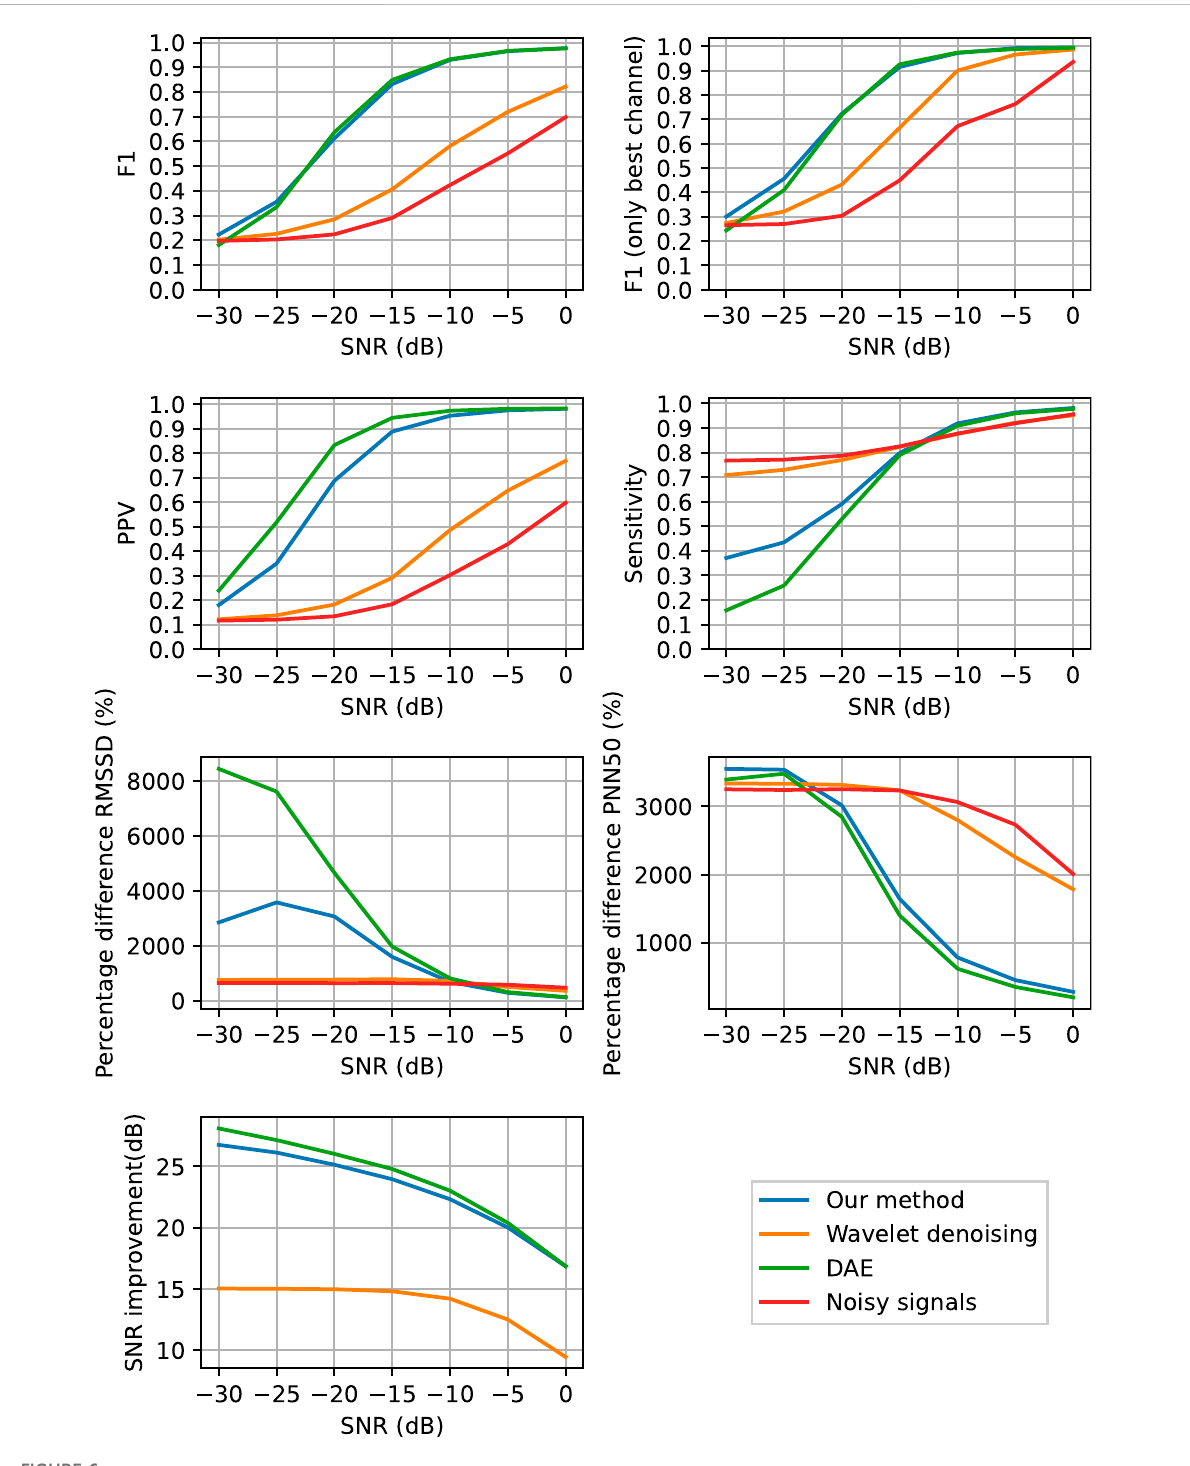
FIGURE 6 Performanceof QRScomplexdetection, heart rate variability feature extraction and denoising as a function of theSNR of theinput signals. The QRS detection was performed in ECG signals that are denoised with the proposed method (blue), with the DAE (green), with the wavelet-based method (orange), and without any denoising